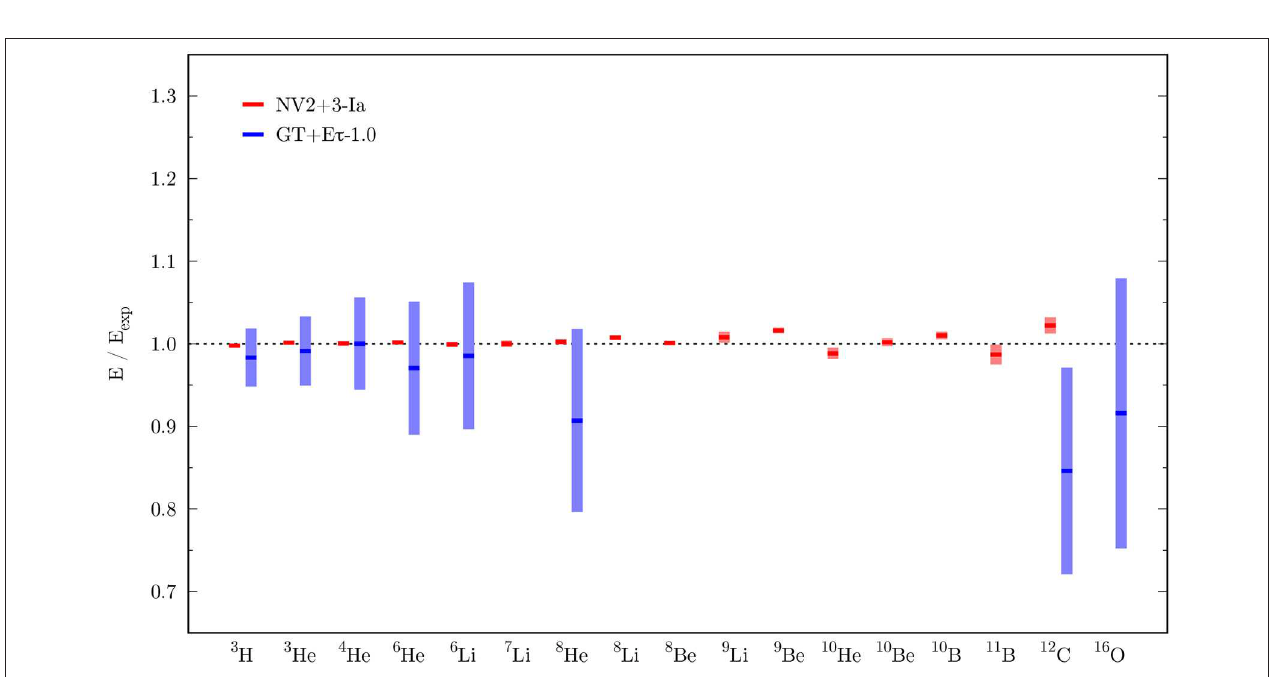
FIGURE 2 | Ground-state energies in A 16 nuclei. For each nucleus, experimental results [122] are shown in green at the center. GFMC (AFDMC) results for the ≤ NV2+3-Ia [11] (GT+E τ -1.0 [89]) potential are shown in red (blue) to the left (right) of the experimental values. For the NV2+3-Ia (GT+E τ -1.0) potential, the colored bands include statistical (statistical plus systematic) uncertainties.